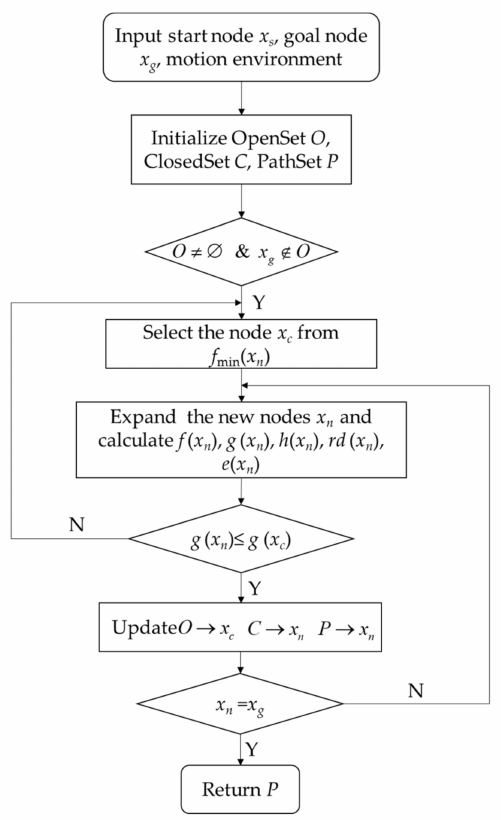
Figure 9. Framework of MOHA*